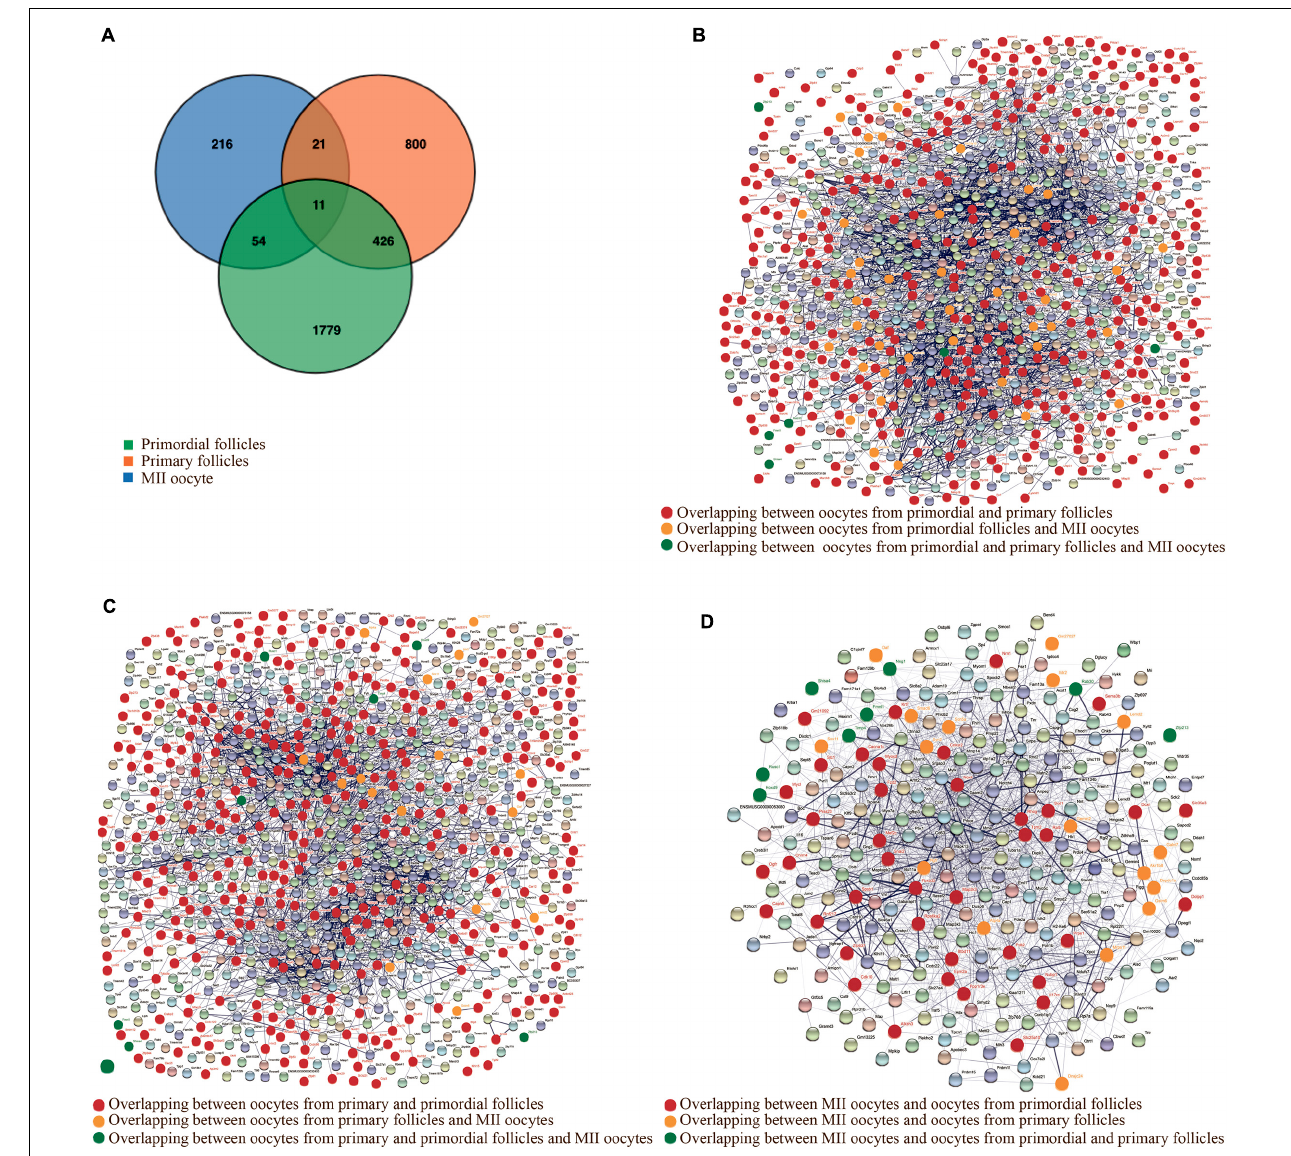
FIGURE 5 | Identification of overlapping significantly differentially expressed genes (SDEGs). (A) Venn diagram representing the overlapping SDEGs between oocytes from primordial and primary follicles and metaphase II (MII) oocytes in the in vitro and in vivo groups. Green, orange, and blue colors show SDEGs of oocytes from primordial follicles, primary follicles, and MII oocytes, respectively. (B) Constructed protein–protein interaction network (PPI) from SDEGs of oocytes from primordial follicles in the in vitro and in vivo groups. Red nodes represent the encoded proteins from overlapping SDEGs between oocytes from primordial and primary follicles in the in vitro and in vivo groups. Yellow nodes show encoded proteins from overlapping SDEGs between oocytes from primordial follicles and MII oocytes. Green nodes refer to encoded proteins from overlapping SDEGs between oocytes from all developmental stages. (C) PPI from SDEGs of oocytes from primary follicles in the in vitro and in vivo groups. Red nodes represent the encoded proteins from overlapping SDEGs between oocytes from primordial and primary follicles in the in vitro and in vivo groups. Yellow nodes show encoded proteins from overlapping SDEGs between oocytes from primary follicles and MII oocytes. Green nodes refer to encoded proteins from overlapping SDEGs between oocytes from all developmental stages. (D) PPI from SDEGs of MII oocytes in the in vitro compared with the in vivo groups. Red nodes represent the encoded proteins from overlapping SDEGs between MII oocytes and oocytes from primordial follicles in the in vitro and in vivo groups. Yellow nodes show encoded proteins from overlapping SDEGs between MII oocytes and oocytes from primary follicles in the in vitro and in vivo groups. Green nodes refer to encoded proteins from overlapping SDEGs between oocytes from all developmental stages.